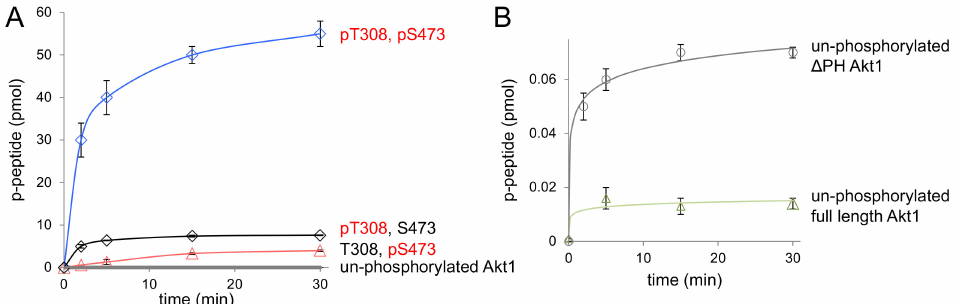
Figure 4. Enzyme activity of ∆ PH-Akt1 variants. ( A ) The activity of differentially phosphorylated ∆ PH Akt1 variants with the GSK-3 β substrate peptide was measured over a 30 min time course. Akt1 phosphorylated at 308 and 473 ( ∆ PH-ppAkt S473,T308 , blue diamonds) showed maximal activity compared to unphosphorylated ∆ PH-Akt1 (gray circles) and singly phosphorylated Akt1 variants ∆ PH-pAkt1 T308 (black diamonds) and ∆ PH-pAkt1 S473 (pink triangles). ( B ) The basal activity of unphosphorylated ∆ PH-Akt1 (gray circles) was compared to full-length unphosphorylated Akt1 (green triangles). All reported values represent the mean of triplicate experiments, with error bars indicating one standard deviation.